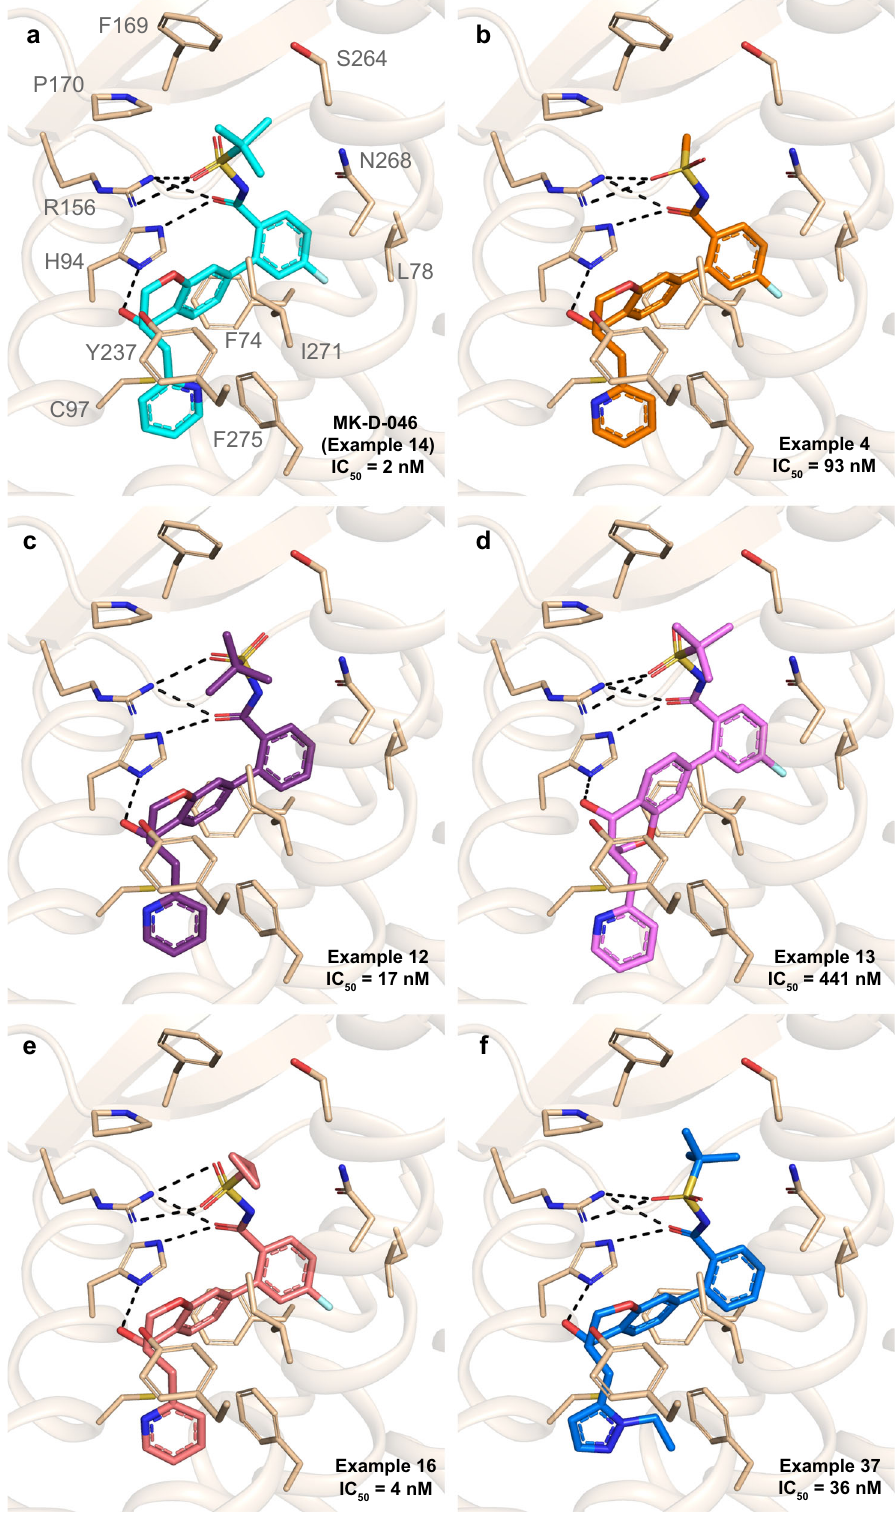
Fig. 4 SAR and docking studies for MK-D-046 and its analogs. a Binding mode of MK-D-046 in hBLT1 as revealed in the crystal structure. b - f Binding modes of Examples 4, 12, 13, 16, and 37 from ref. 24 obtained by docking in the hBLT1 structure. Inhibition potencies (IC 50 ) for all ligands, obtained using LTB4-induced cAMP assays in hBLT1-expressing HEK293 cells, were taken from ref. 24 . Hydrogen bonds are shown as dashed